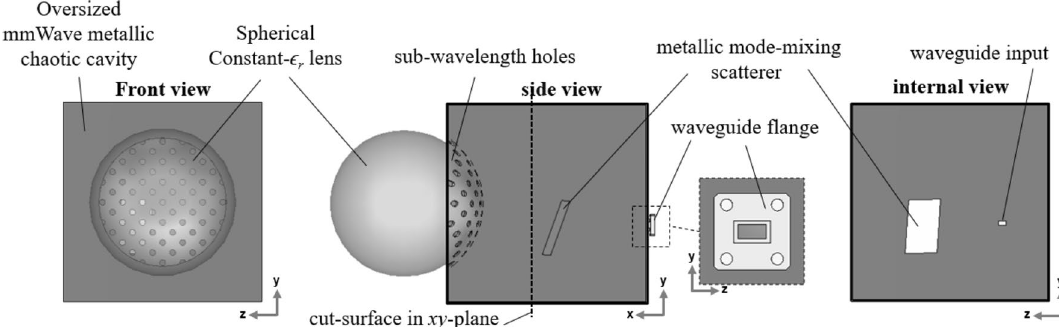
Figure 2. Frequency-diverse multimode millimetre-wave lens-loaded cavity with a front, internal side and internal front elevations.